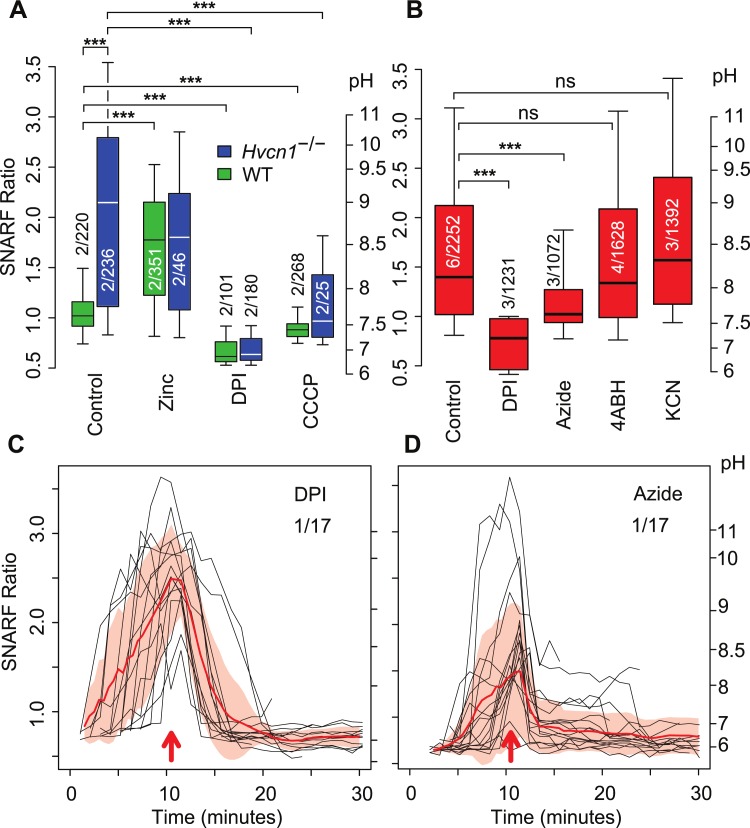
The effect of DPI, azide, 4ABH, KCN, zinc, and CCCP on vacuolar pH.(A) The effect of 300 μM Zn2+, DPI and 60 μM CCCP on vacuolar pH in WT and Hvcn1
-/- neutrophils at ~30 minutes following the addition of Candida without synchronisation to particle uptake. (B) The effect of 5 μM DPI, 5 mM sodium azide, 50 μM 4ABH and 1mM KCN, on vacuolar pH in human neutrophils at ~30 minutes following the addition of Candida without synchronisation to particle uptake. The effect of the addition of azide (C) or DPI (D) on vacuolar pH in human neutrophils synchronised to time of addition (red arrows). The numbers of independent experiments is shown over the total number of measurements. Median, quartiles and 95% centiles are shown. Statistical significance: *** p<0.001.